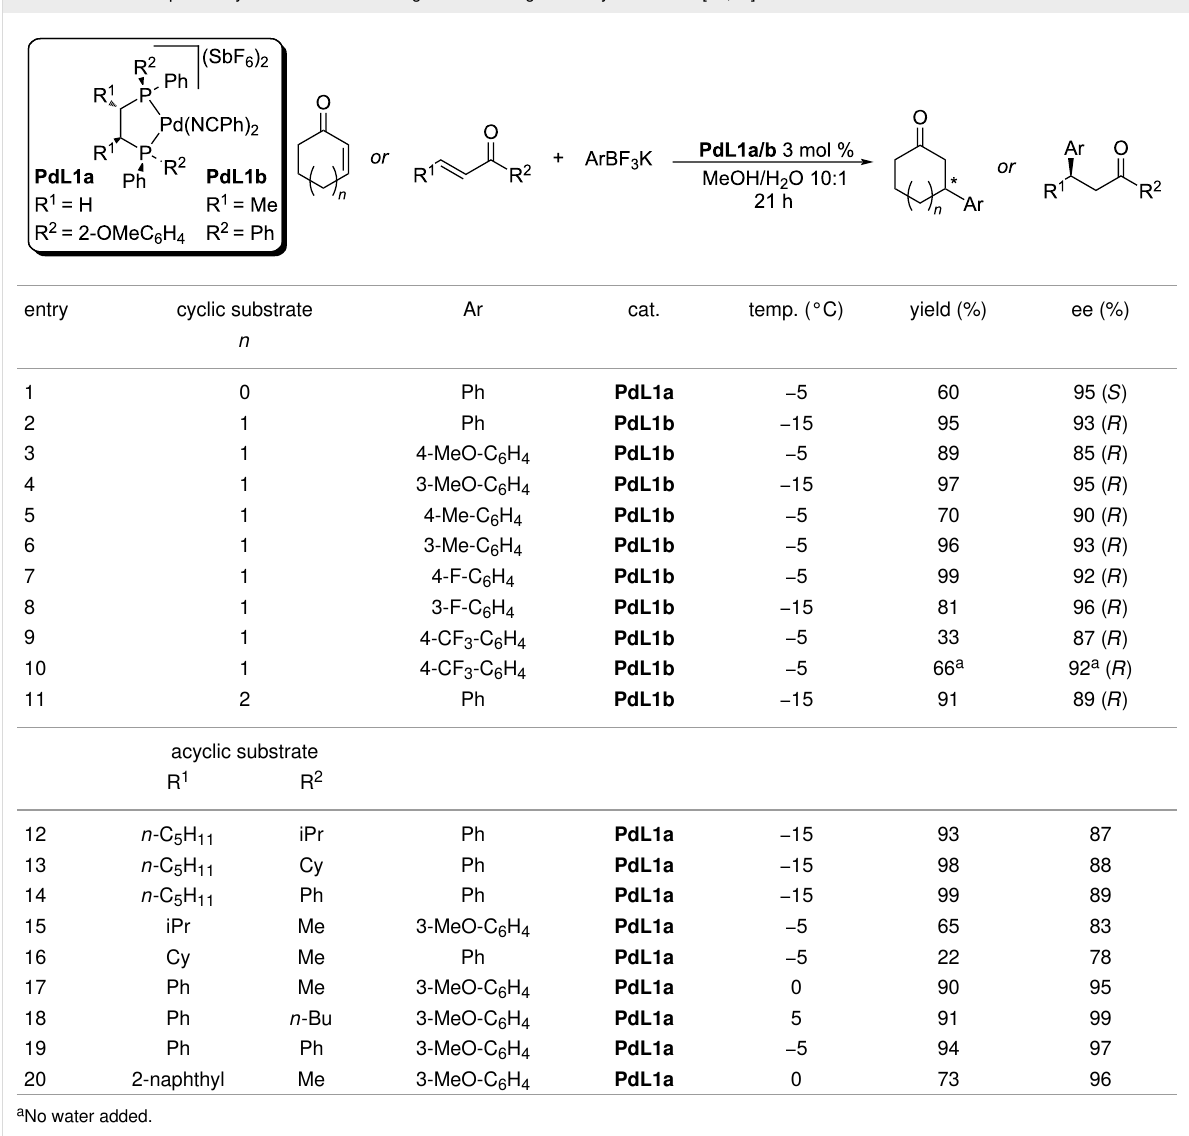
Table 1: First example of asymmetric addition of organoboron reagents to cyclic enones [32,33].